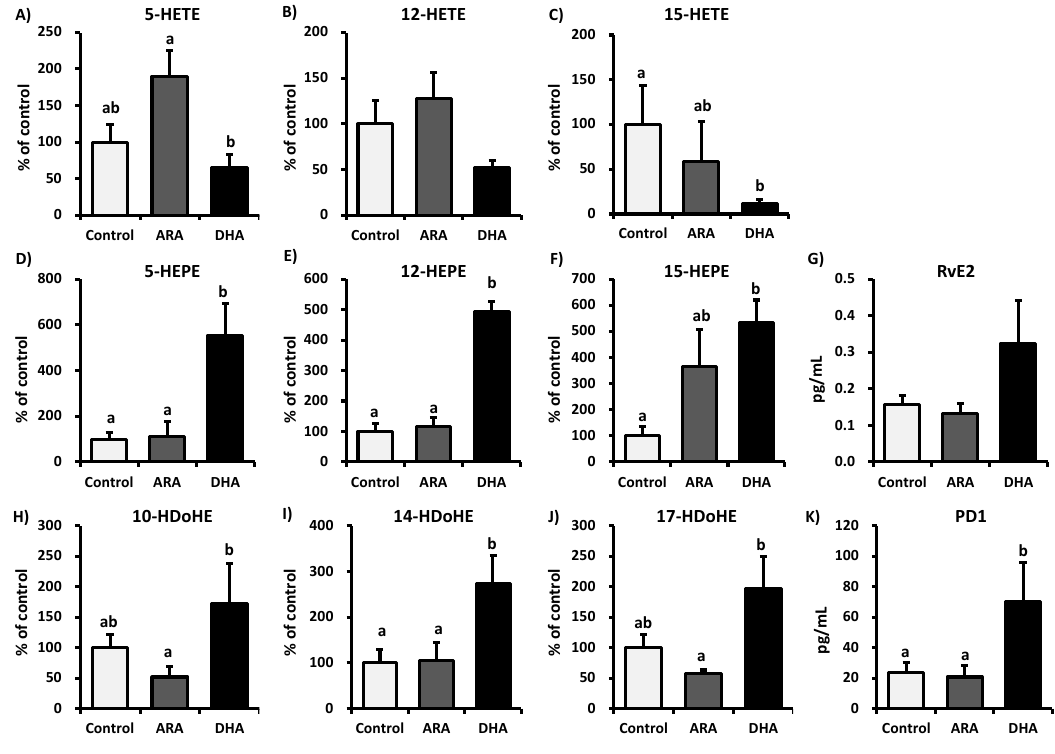
Figure 3. Plasma levels of ARA, EPA, and DHA metabolites generated by LOXs. Plasma samples were subjected to LC-MS/MS lipidomic analysis. The values are expressed as the mean ± S.E. ( n = 8) percentages relative to the control. The graph presents the plasma levels of the metabolites from ARA, EPA, and DHA: ( A ) 5-HETE, ( B ) 12-HETE, ( C ) 15-HETE, ( D ) 5-HEPE, ( E ) 12-HEPE, ( F ) 15-HEPE, ( G ) RvE2, ( H ) 10-HDoHE, ( I ) 14-HDoHE, ( J ) 17-HDoHE, and K ) PD1. Samples were analyzed using a one-way ANOVA followed by a Bonferroni post hoc test. a, b Different letters indicate statistical differences at p < 0.05 .